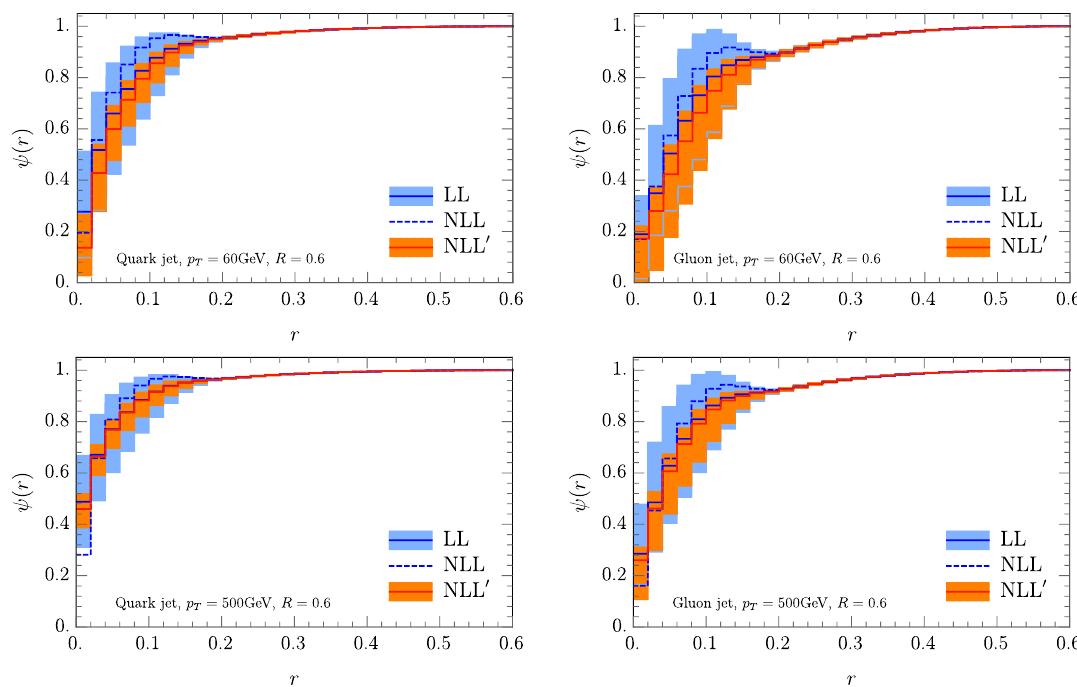
Figure 8 . The integrated jet shape for quark jets (left) and gluon jets (right) for p T = 60 GeV (top) and 500 GeV (bottom) and R = 0 : 6. Shown are LL (blue solid curve and band), NLL (blue dashed curve) and NLL 0 (orange solid curve and band), all matched to NLO. The bands indicate the perturbative uncertainties estimated using the procedure in section